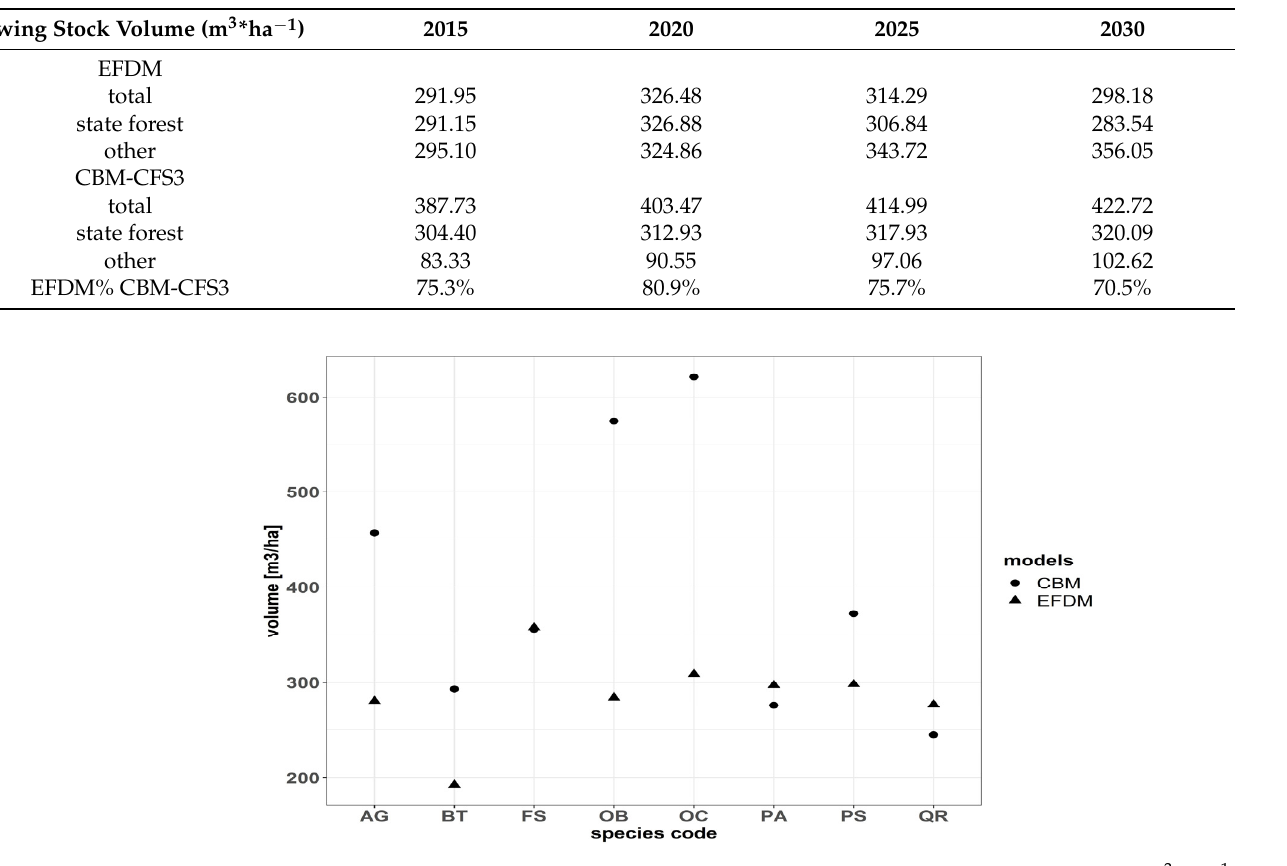
Table 3. Growing stock volume (m 3 *ha − 1 ): comparison between the two models EFDM and CBM-CFS3.